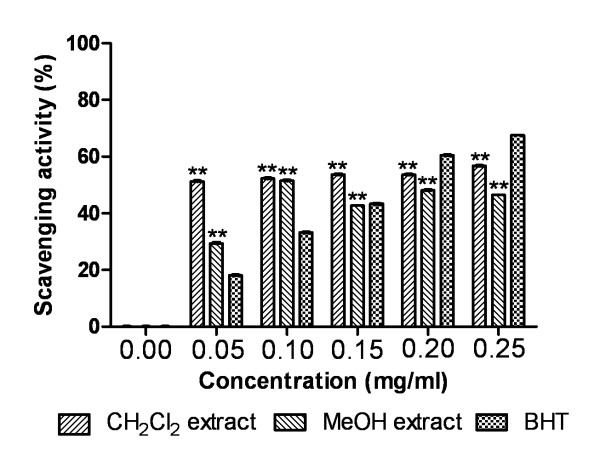
Nitric oxide radical scavenging activity. Effect of Dragon's blood resin extracts and standard BHT on nitric oxide scavenging assay. The percentage of scavenging was plotted against concentration of samples. **P < 0.0001 vs 0 μg/ml.